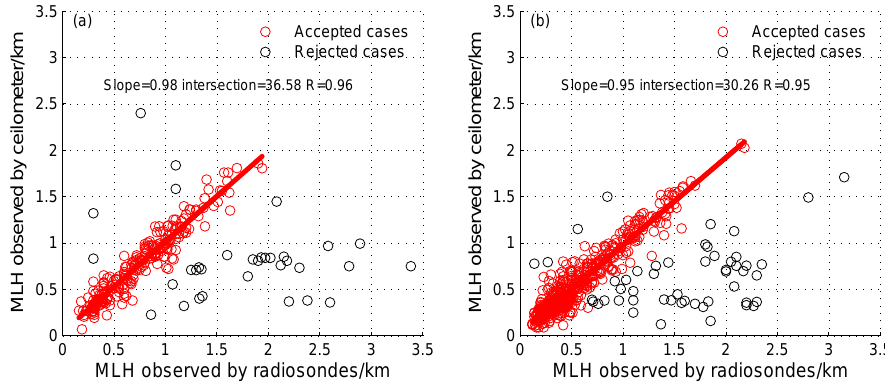
Figure 6. Comparison of MLH between the ceilometer and radiosondes for convective (a) and stable (b) states.